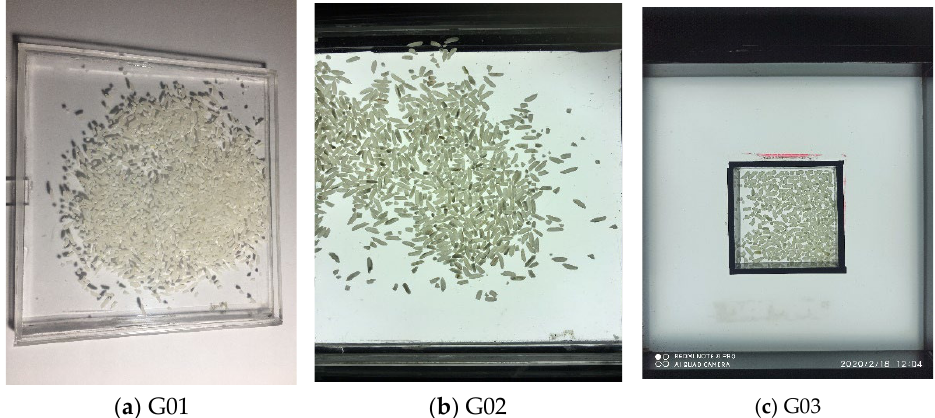
Figure 2. Examples of image acquisitions for analysis: ( a ) G01 comprises natural white light (60 W), ( b ) G02 comprises randomly scattered backlit images with white light source (60 W), and ( c ) G03 comprises white backlit images (60 W) of grains scattered in a single layer.